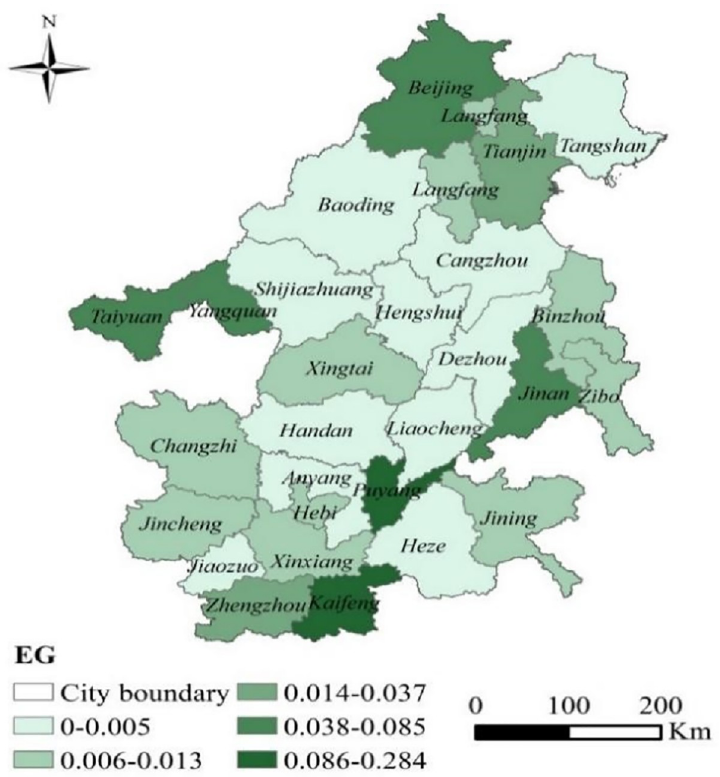
Fig 2. EG index of the BTH “2+26” cities. The map was prepared in ARCGIS using political boundaries from the Global Database of Administrative Areas (https://resources.arcgis.com/en/help/).